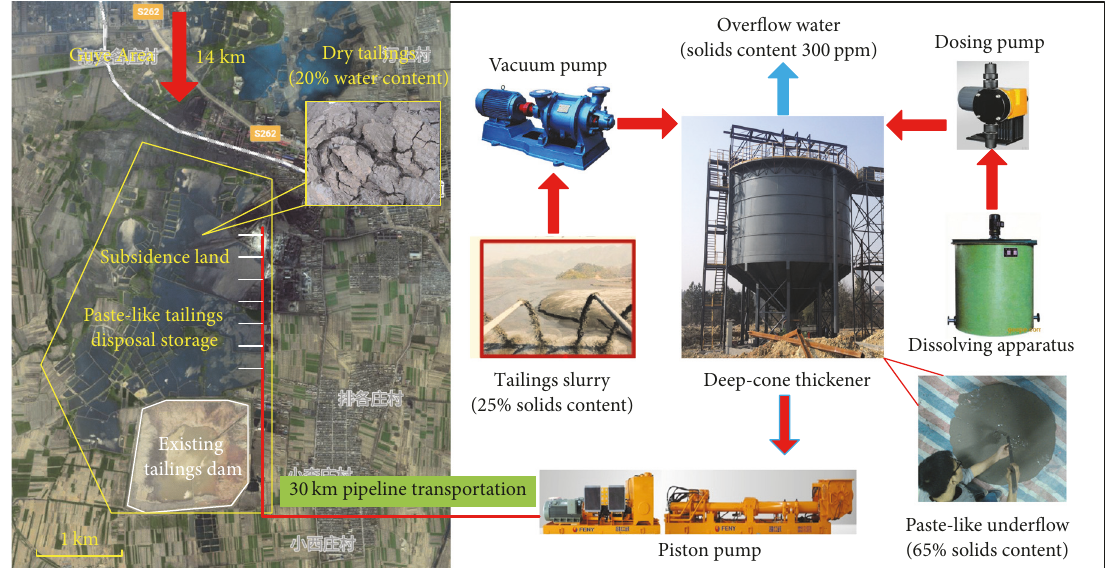
Figure 2: The preparation and transportation of PLTS in Sijiaying.